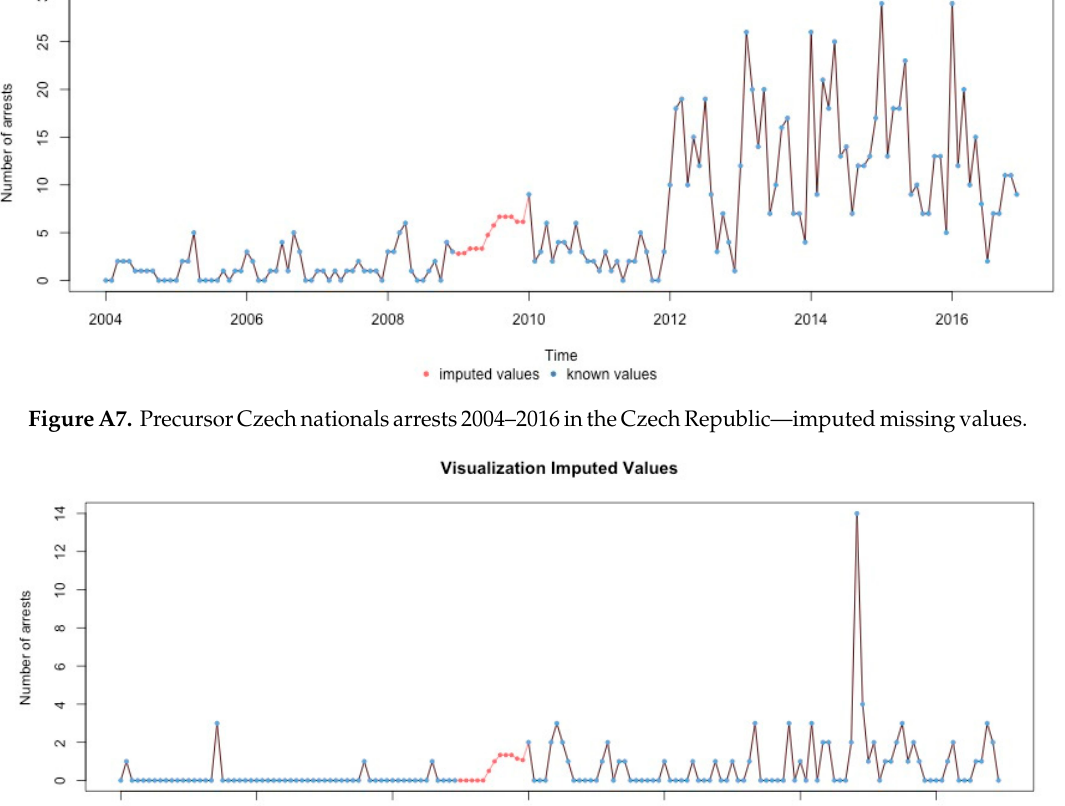
Figure A9. Precursor Vietnam nationals arrests 2004–2016 in the Czech Republic – imputed missing values.